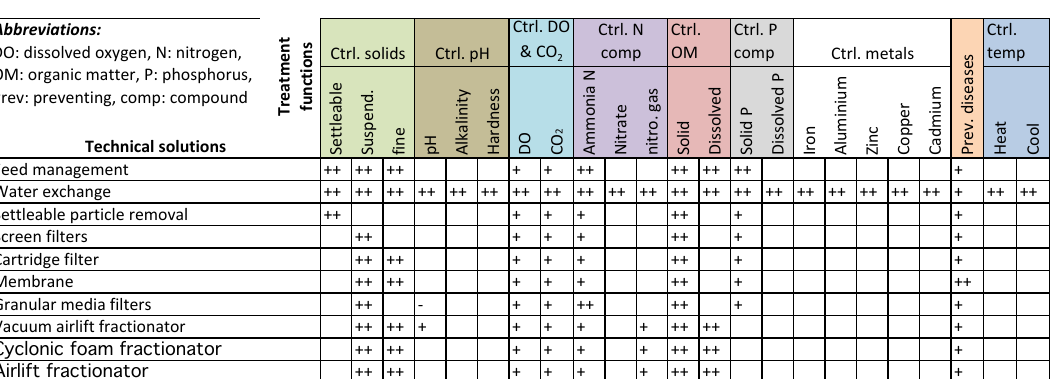
Table 2. QFD matrix presenting how feed management, water exchange and solid removal techniques influence different treatment